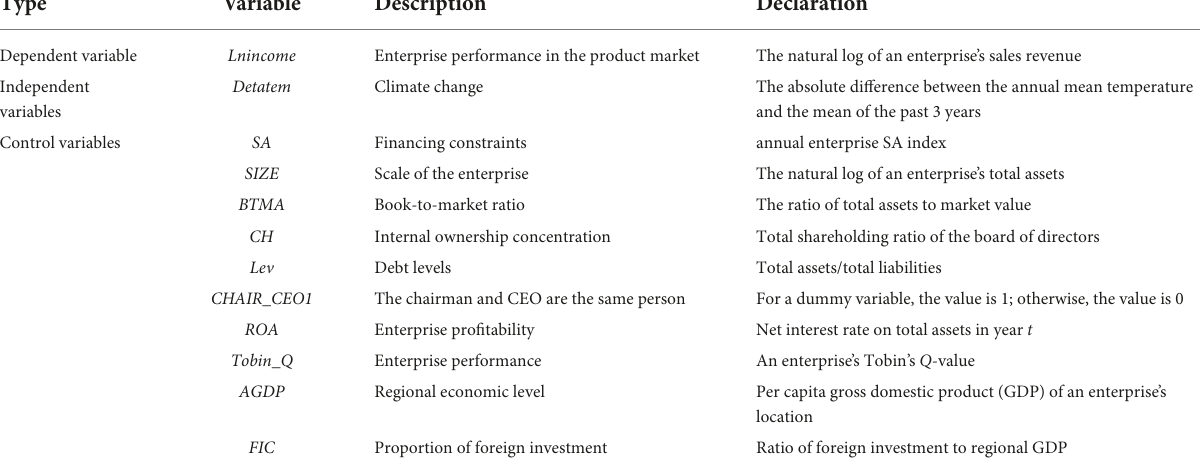
TABLE 1 Variable